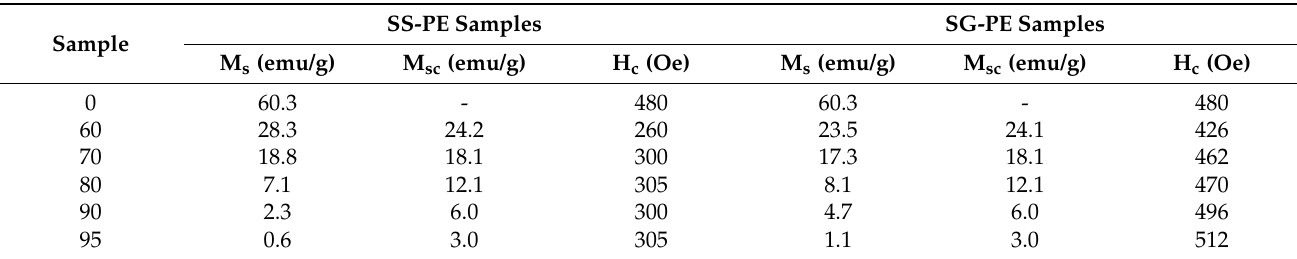
Table 4. Experimental (M s ) and calculated (M sc ) saturation magnetization and coercive field (H c )